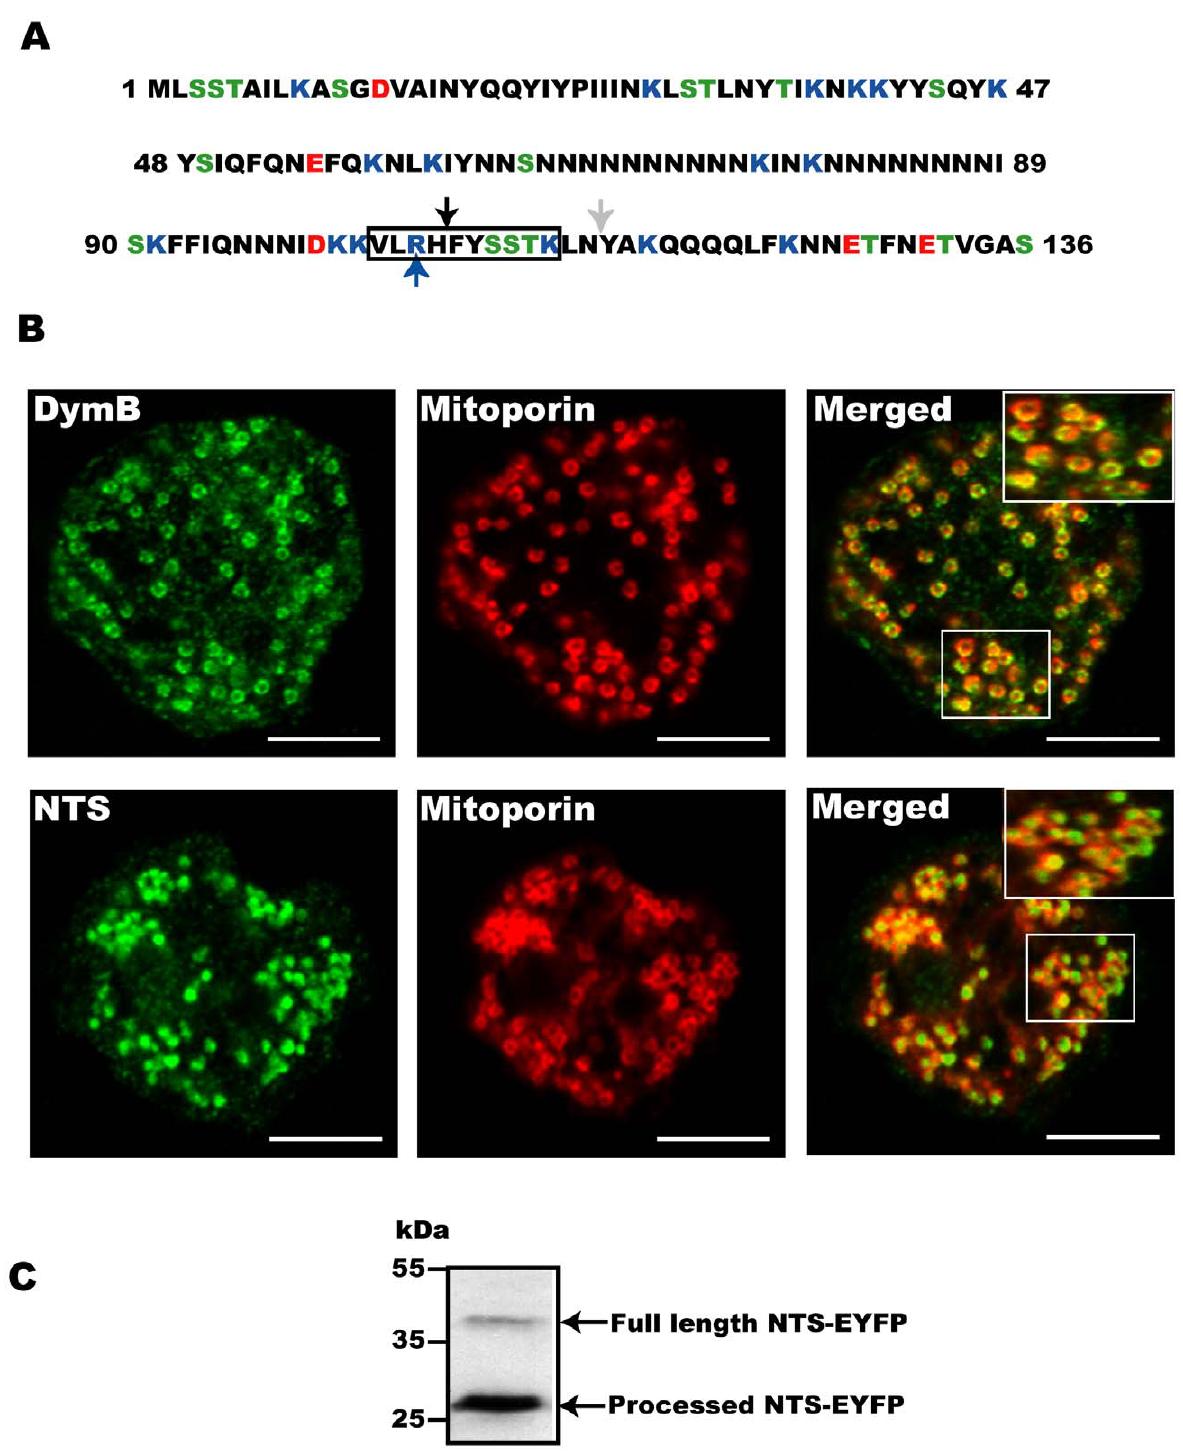
Figure 1. The dynamin B NTS is sufficient for mitochondrial targeting. ( A ) N-terminal 136 amino acid sequence of dynamin B. Positively charged amino acid residues are shown in blue, negatively charged residues in red, and serine and threonine residues in green. The black box marks the predicted R-like recognition sequence. Predicted MPP and MIP cleave sites are indicated by black and gray arrows, respectively. Arginine 105 is marked by a blue arrow. ( B ) The dynamin B presequence contains a functional mitochondrial targeting signal. The upper panel shows AX2 cells transformed with pDXA/DymB-EYFP (control). The lower panel shows AX2 cells transformed with pDXA/NTS-EYFP. Cells were fixed and immuno- stained as described in material and method. Single plane confocal images are shown. Scale bars, 5 m m. ( C ) The dynamin B presequence is processed upon mitochondrial translocation. Intact mitochondria from AX2 cells overproducing NTS-EYFP were purified, separated on 15% SDS-PAGE, blotted and probed with affinity purified mouse anti-GFP antibody.